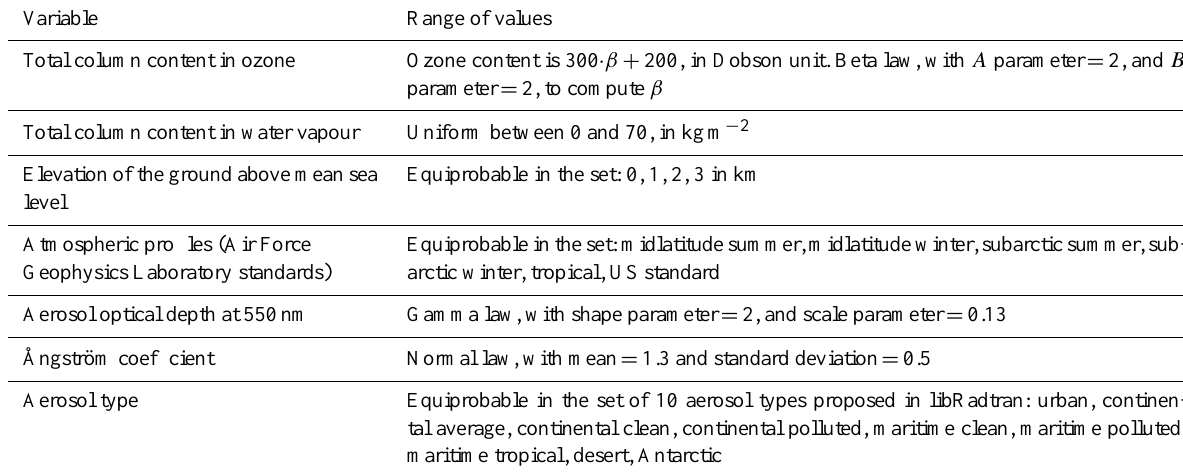
Table 4. Range of P c values (seven variables describing the clear